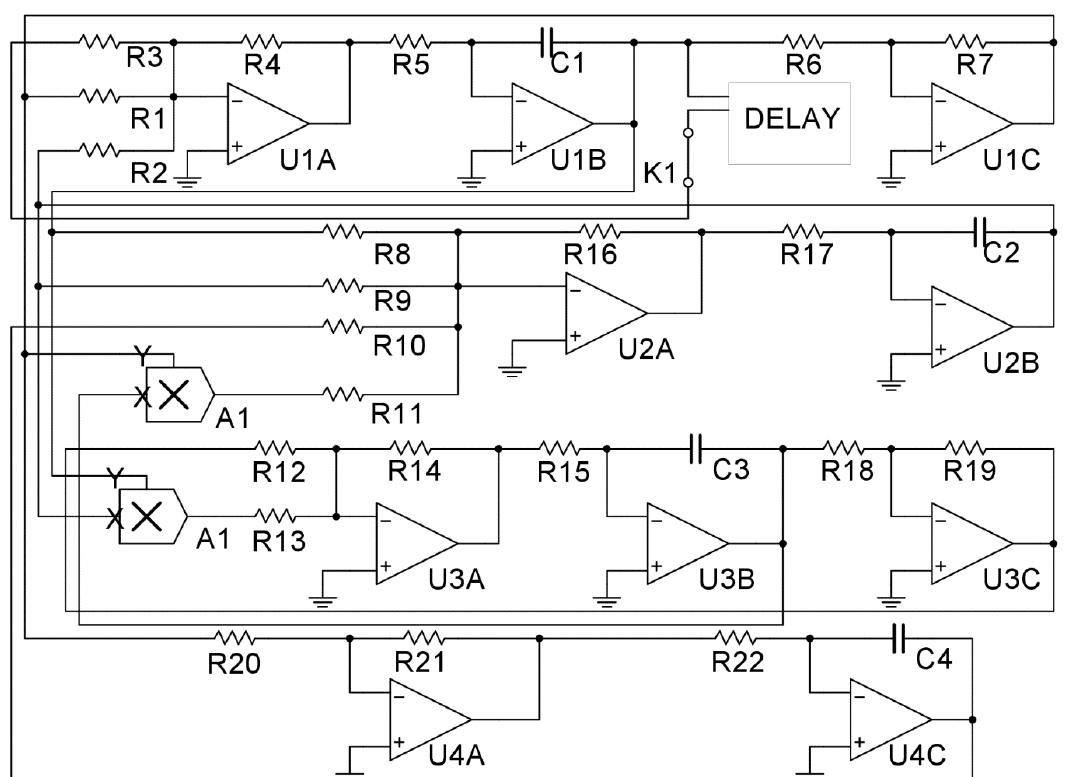
Figure 10. Time-delay Lorenz chaotic circuit.